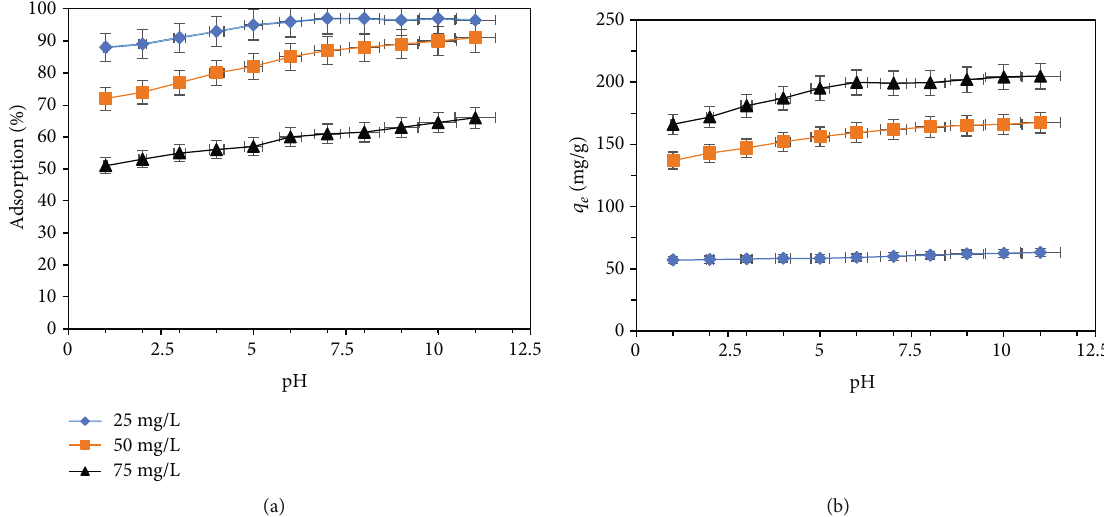
Figure 9: (a) Adsorption rate and (b) adsorption capacity of CV onto ACMAS at T = 303K , contacttime = 120 min , and CVdose = 0 : 15g/L